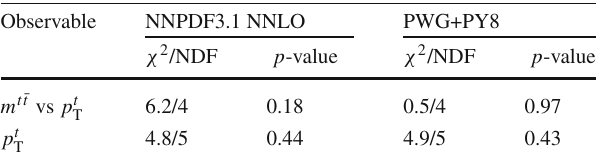
Table 27 Comparison of the measured parton-level normalised differ- entialcross-sectionsintheboostedtopologywiththeNNLOpredictions and the nominal Powheg + Pythia8 predictions. For each prediction a χ 2 and a p -value are calculated using the covariance matrix of the measured spectrum. The NDF is equal to the number of bins in the distribution minus one